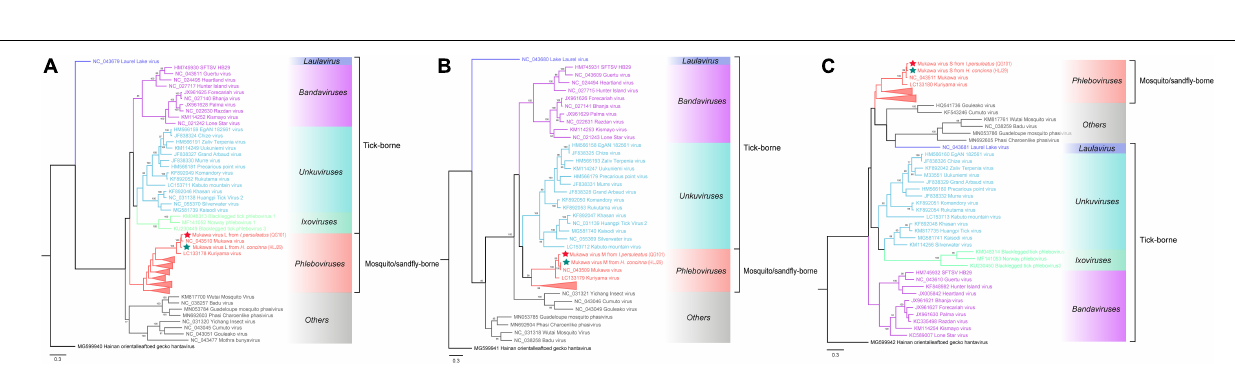
FIGURE 3 | Phylogenetic analysis of MKWV RNA segments. (A) The ML phylogenetic tree constructed based on a 5,672-bp fragment of the partial L segment. (B) The ML phylogenetic tree constructed based on the full-length nucleotide sequences of the M segment. (C) The ML phylogenetic tree constructed based on the full-length nucleotide sequences of the S segment. Our MKWV from I. persulcatus was labeled with a red solid five-pointed star, and our MKWV from H. concinna was labeled with a green solid five-pointed star. Trees that were generated using MEGA-X and analyzed included 1,000 bootstrap